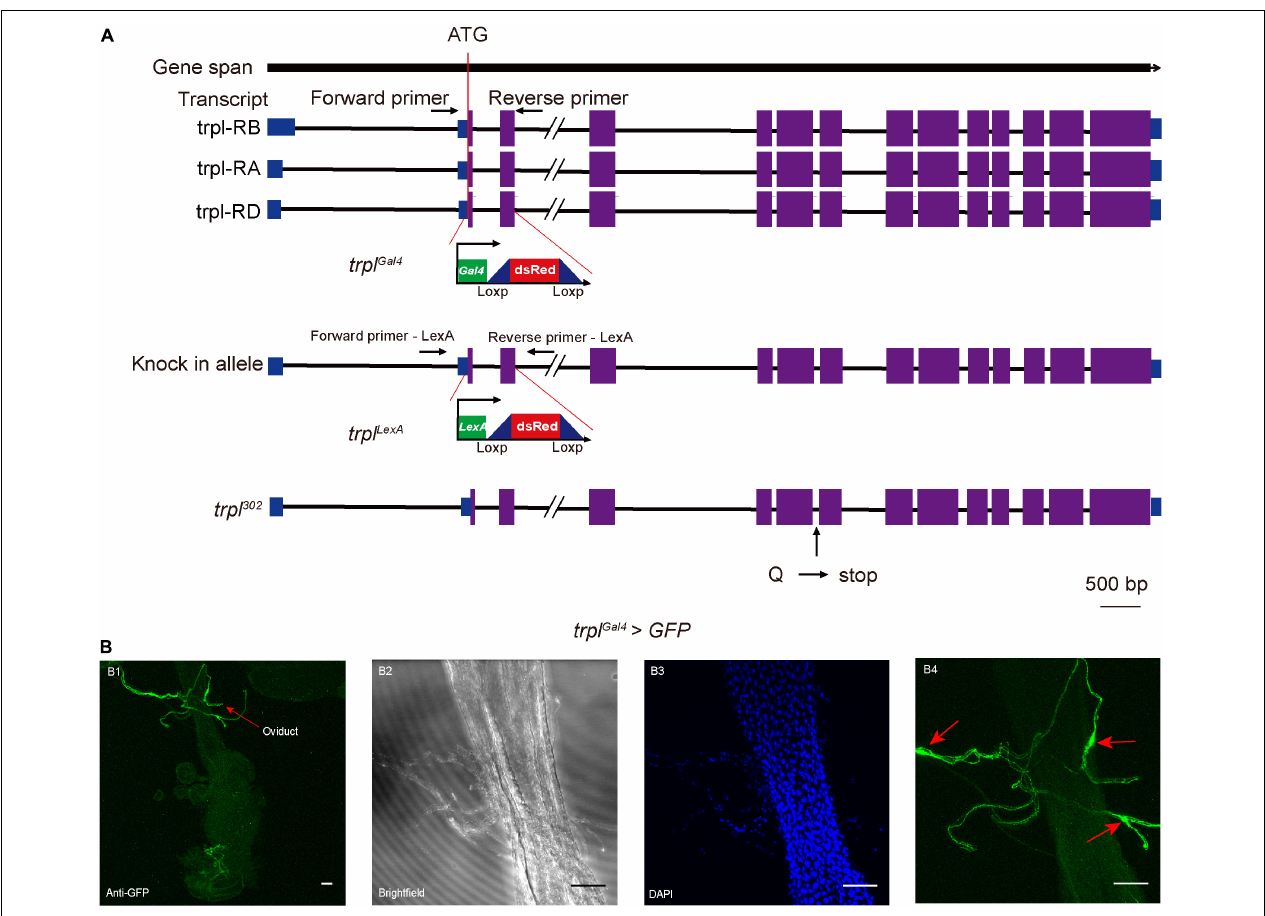
FIGURE 4 | Expression patterns of TRPL on the reproductive organ of female Drosophila . (A) Generation of the trpl reporter and mutant alleles. (B) Expression of UAS-mCD8-GFP in sensory neurons innervating the female oviduct under control of trpl Gal 4 ( trpl > mCD8-GFP ) (B1–B4) . Arrows in (B1,B4) indicate the somas of sensory neurons. Scale bars, 50 µ